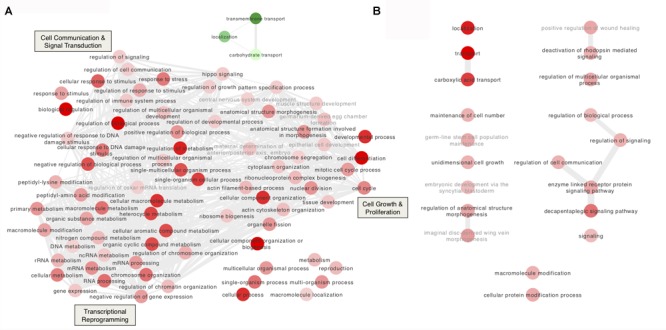
Gene Ontology (GO) enrichment analysis of the differentially expressed genes in bacteriocytes from aphids reared on the tyrosine and phenylalanine depleted diet. (A,B) Interactive graphs of the GO biological processes that are differentially expressed at Day 3 (A) and at Day 5 (B). The thickness of the edges corresponds to the number of shared genes. Red and green indicate up- and down-regulation, respectively. The color density of the nodes is proportional to the FDR adjusted P-values. Irrelevant GO terms for the bacteriocyte cell were labeled in gray.